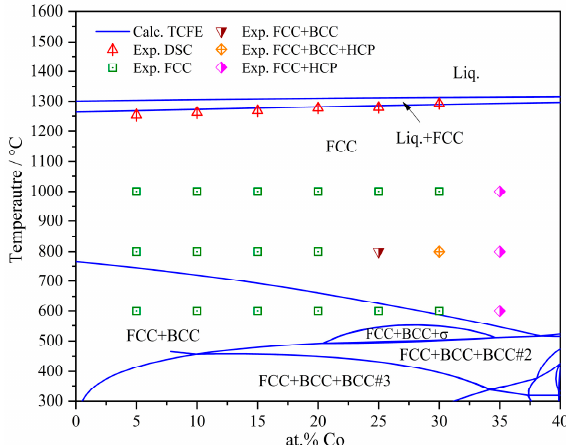
Figure 5. A vertical section of the Co x CrFeMnNi 2 − x system calculated using the TCFE database. The phase constituents in the annealed and quenched alloys and the DSC results are shown in the figure.